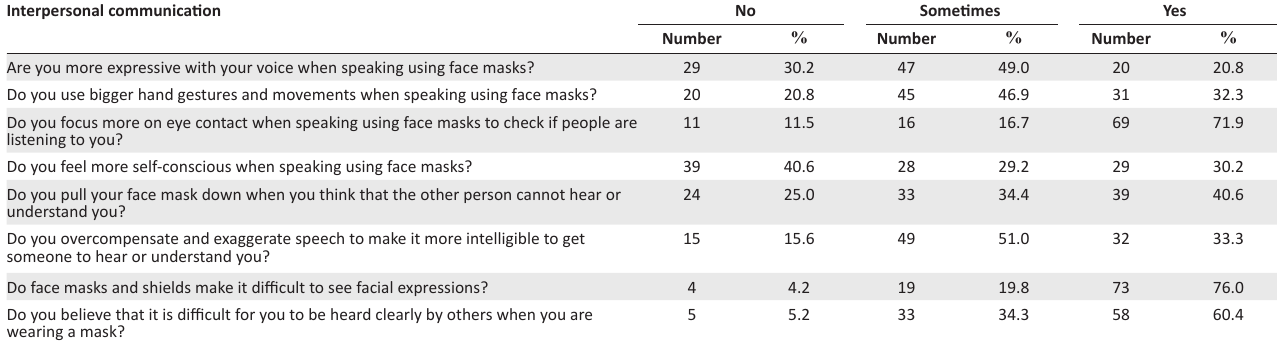
TABLE 2: Summary of interpersonal communication. Interpersonal